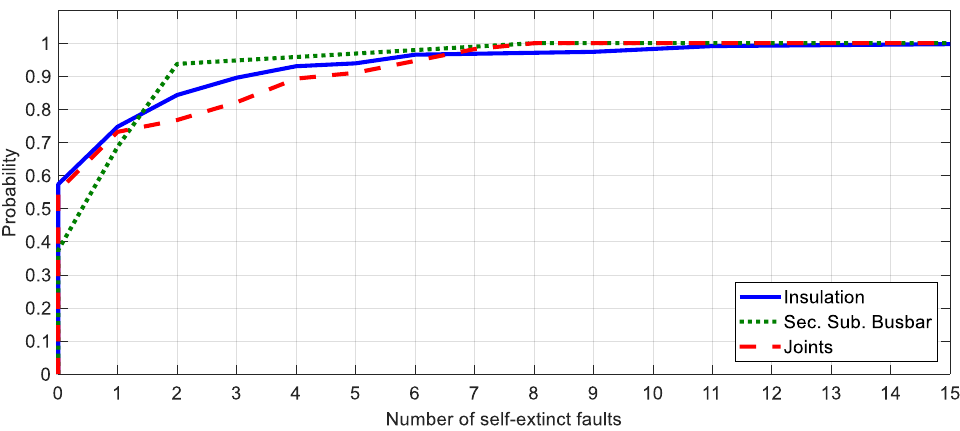
Figure 2. Observed cumulative probability for the number of self-extinct faults. Self-extinct faults numbering above eight have only been observed for cable insula- tion failures.